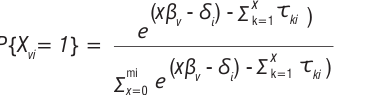
Figure 1: Item characteristic curve for an item located at -2.266 logits, representing a 0.5 probability of a correct answer.